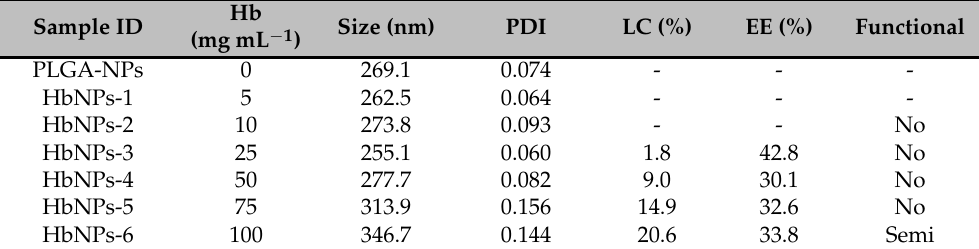
Table 1. Effects of the Hb concentration on the size, polydispersity (PDI), loading content (LC), entrapment efficiency (EE), and functionality of the resulting HbNPs 1